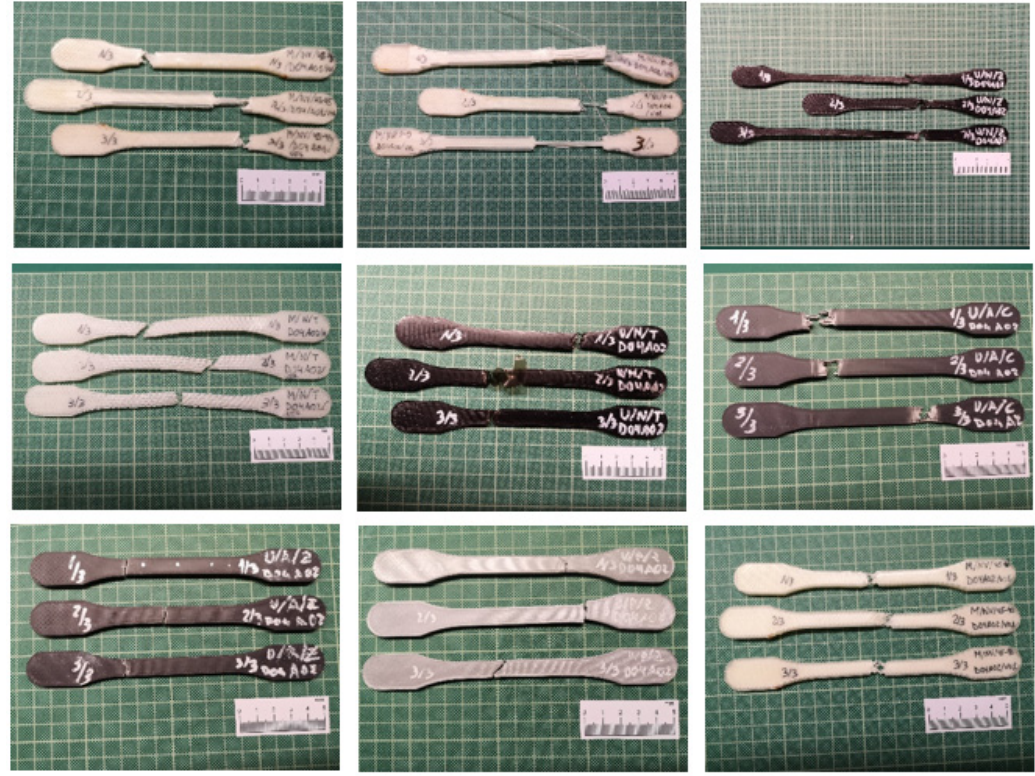
Figure 3. Polymer and composite specimens. Table 2. Ultimaker and Markforged technical specifications.